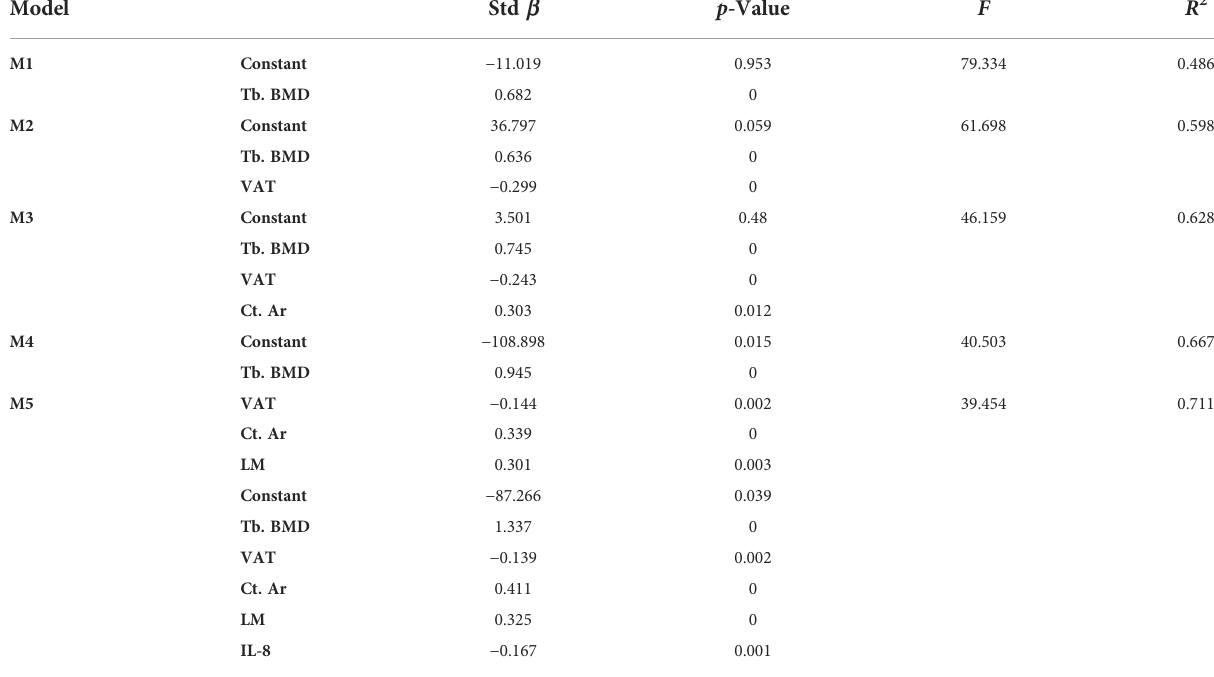
TABLE 3 Stepwise multivariate analysis of BMD, body compositions, and blood parameters.